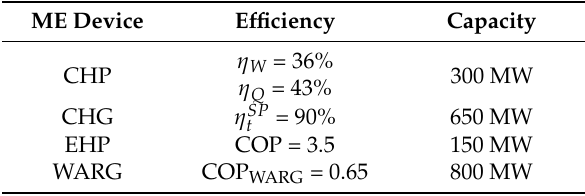
Table 3. Generation unit characteristics 2.